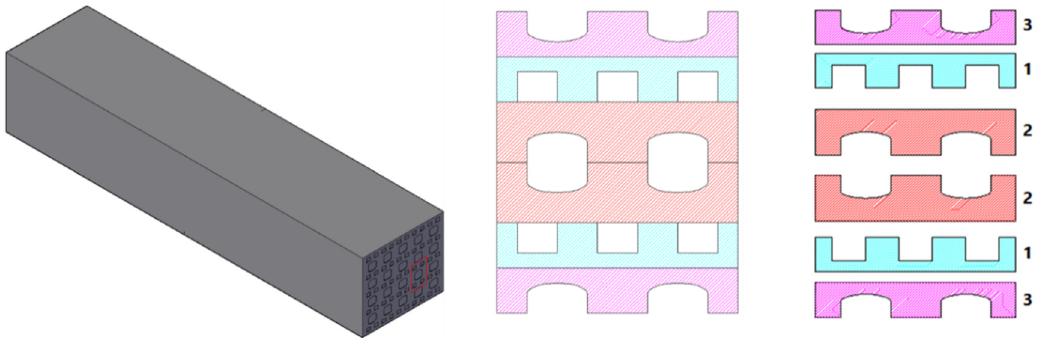
Figure 1. The schematic illustration of the printed circuit heat exchanger (PCHE).